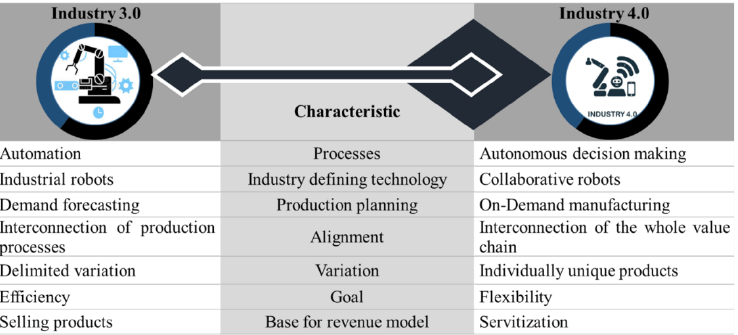
Figure 1. Comparison of Industry 3.0 and Industry 4.0 manufacturing